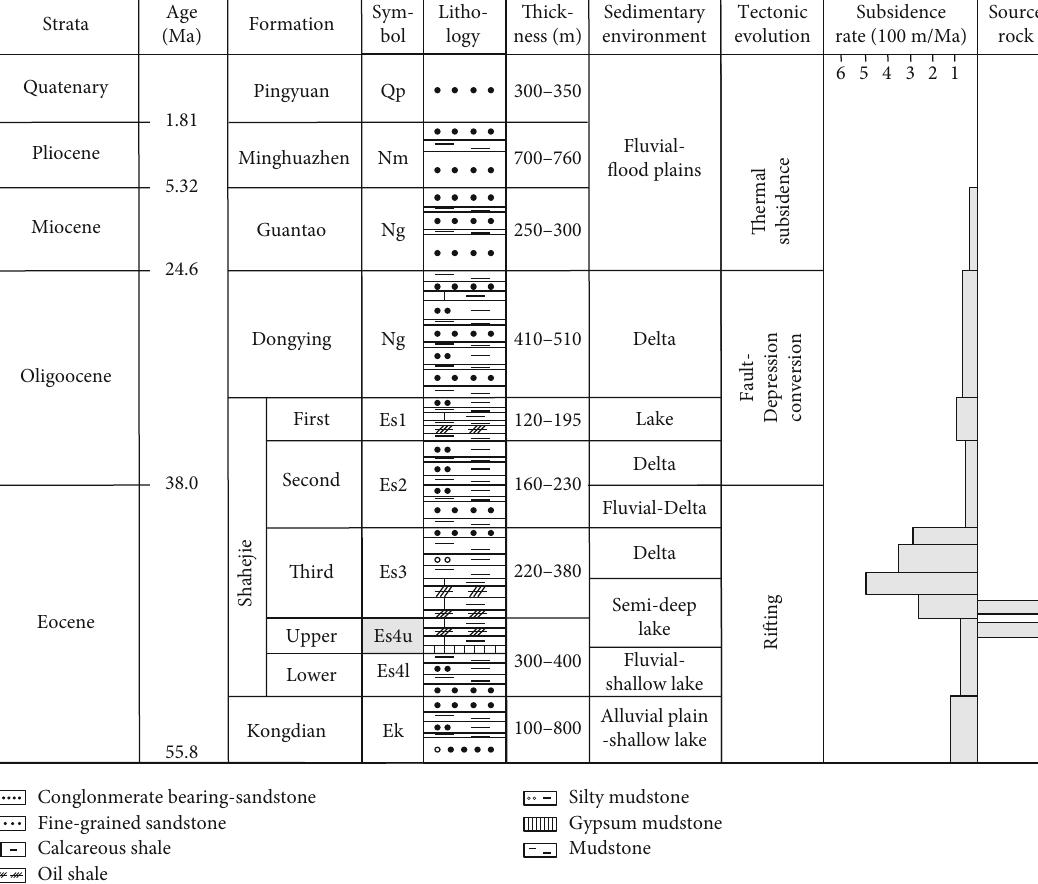
Figure 2: Stratigraphic column of the Dongying Depression (modi fi ed from